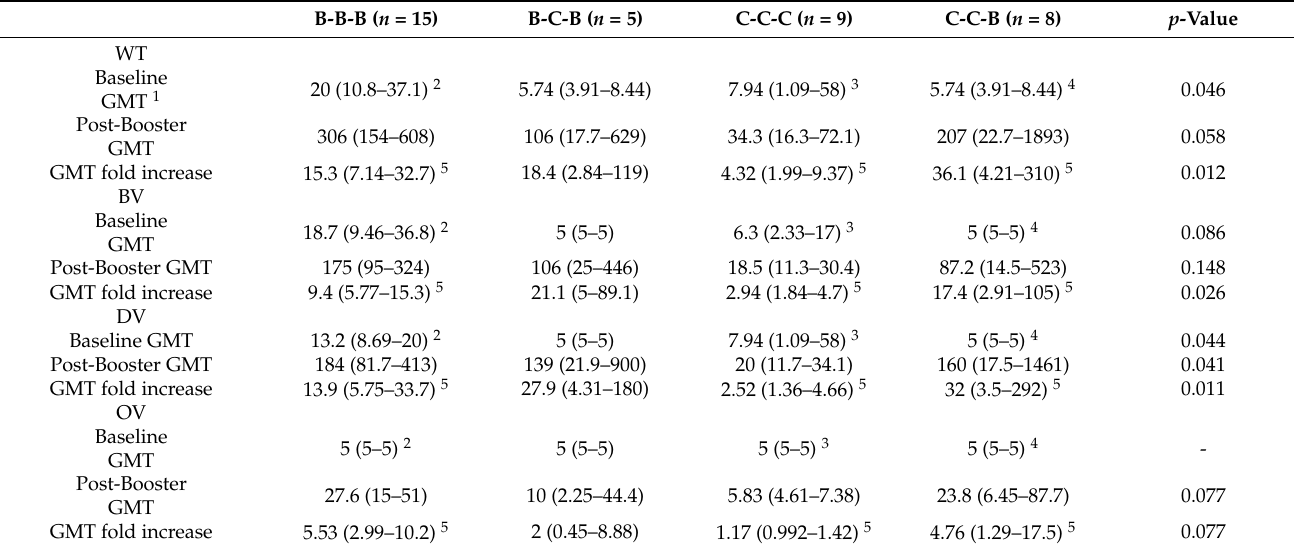
Table 2. Immunogenicity of different vaccine